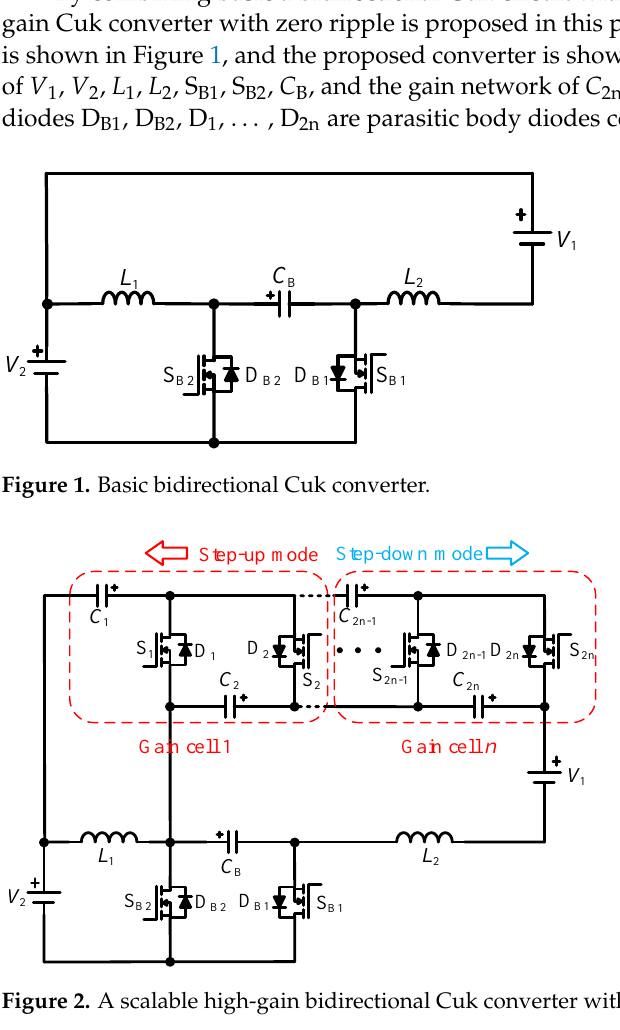
Figure 2. A scalable high-gain bidirectional Cuk converter with zero ripple.